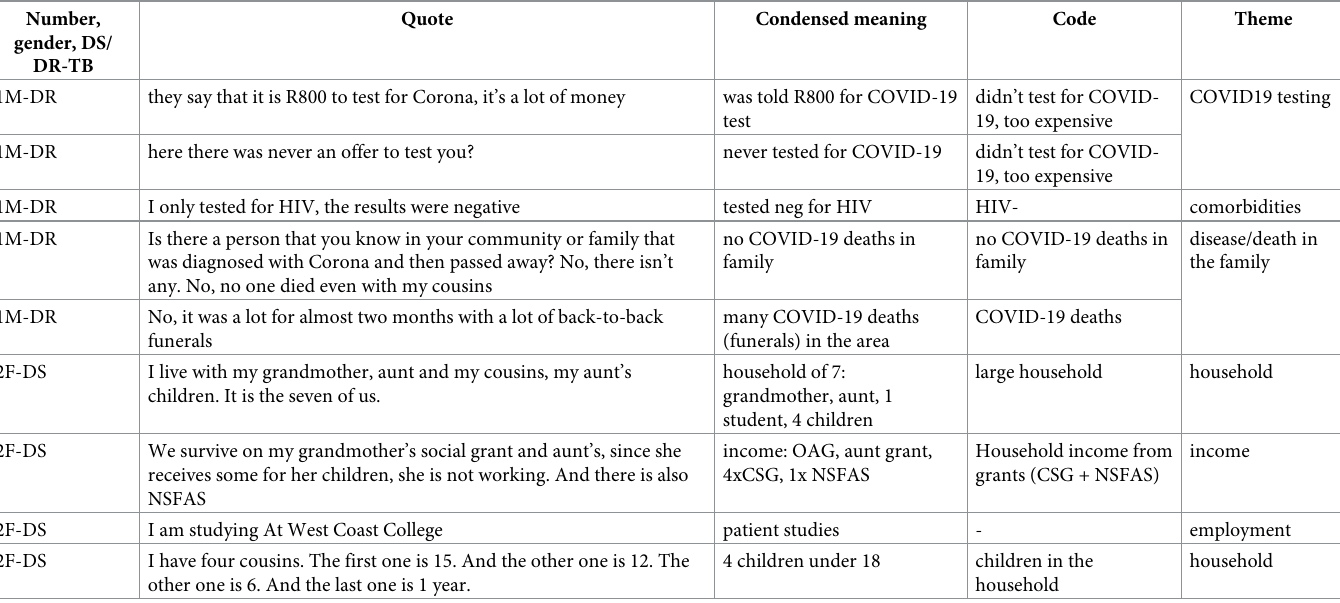
Table 2. Example of